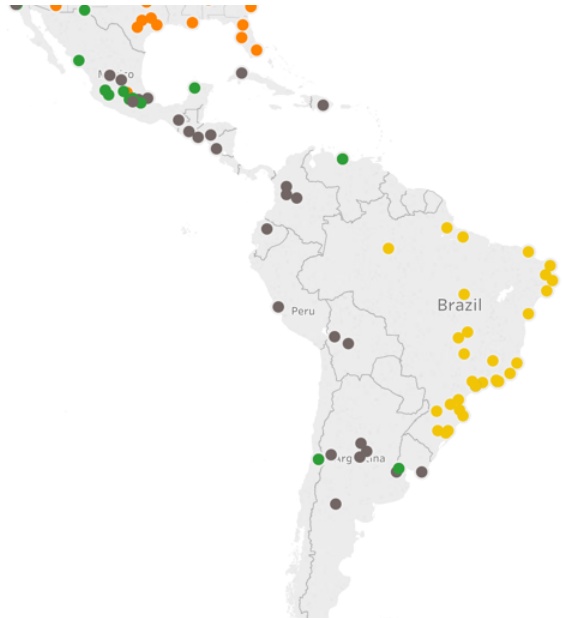
Figure 2. Members of the Latin American networks ANPUR (yellow), ALEUP (green) and CLACSO (grey). Source: